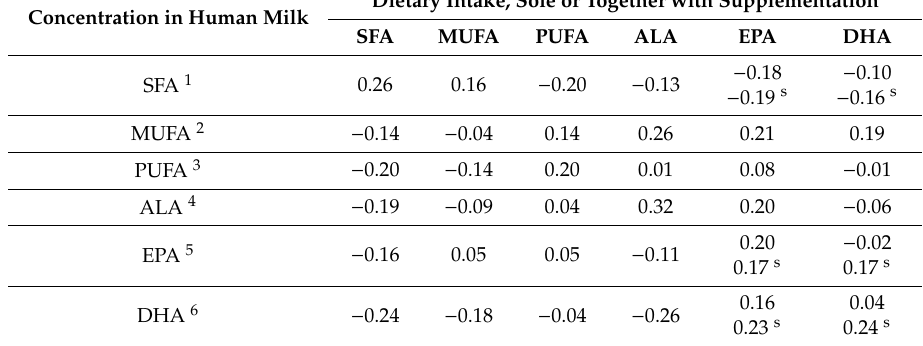
Table 5. Correlations between human milk fatty acids and fatty acids in the mother’s diet and